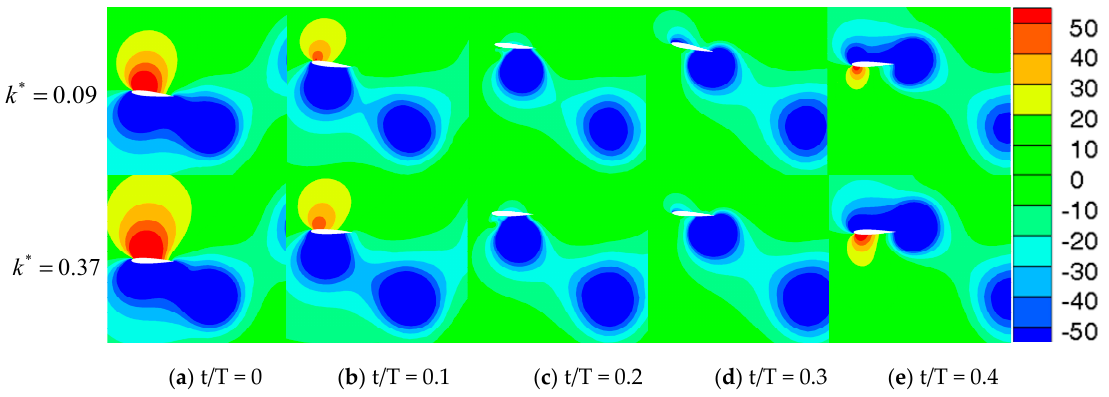
Figure 15. Evolution of ( a ) the thrust coe ffi cient and ( b ) the pitching profile at k ∗ = 0.09, 0.27, 0.37, y 0 = 0.2, f ∗ = 0.17.